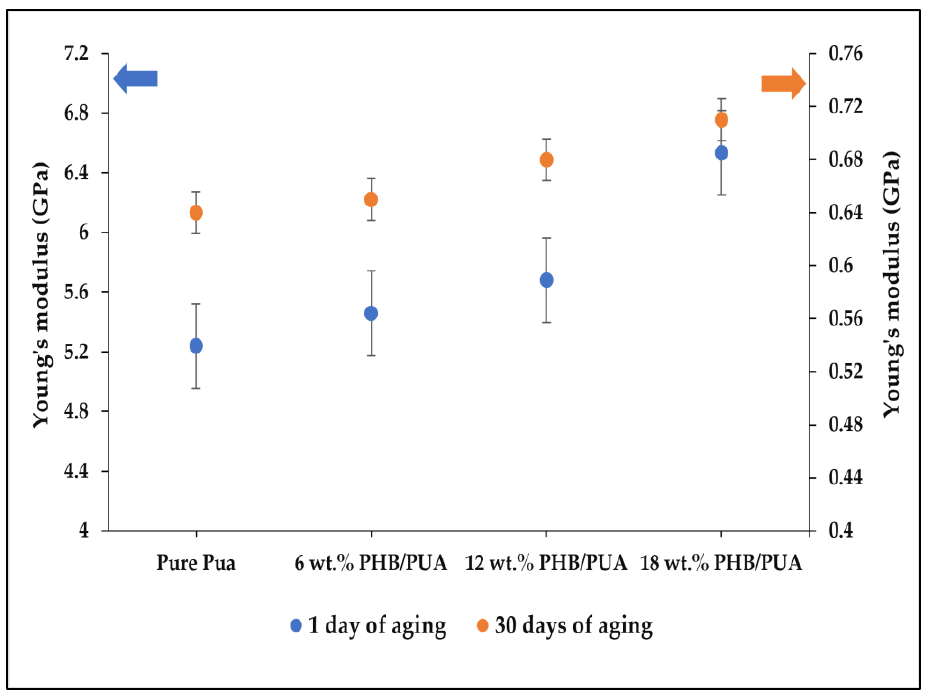
Figure 8. Young’s modulus of various 3D-printed PHB/PUA compositions at different aging durations.